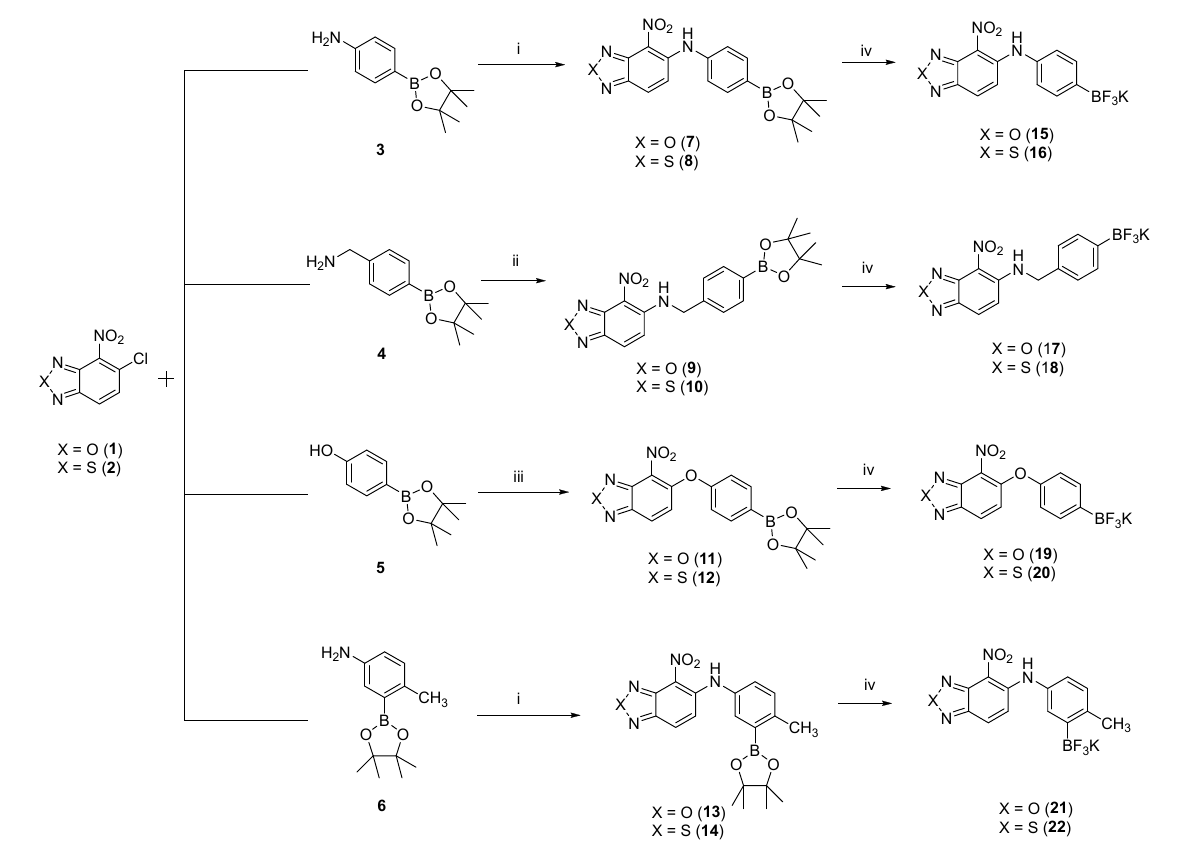
Scheme 1. General synthetic scheme of boron-based compounds. Reagents and conditions: (i) DMF, 90 °C, 3 h; (ii) t BuONa, DMF, room temperature (25 °C), 16 h; (iii) Et 3 N, ACN, room temperature (25 °C), 16 h (iv) KHF 2 (3M), MeOH, room temperature (25 °C), 2 h.